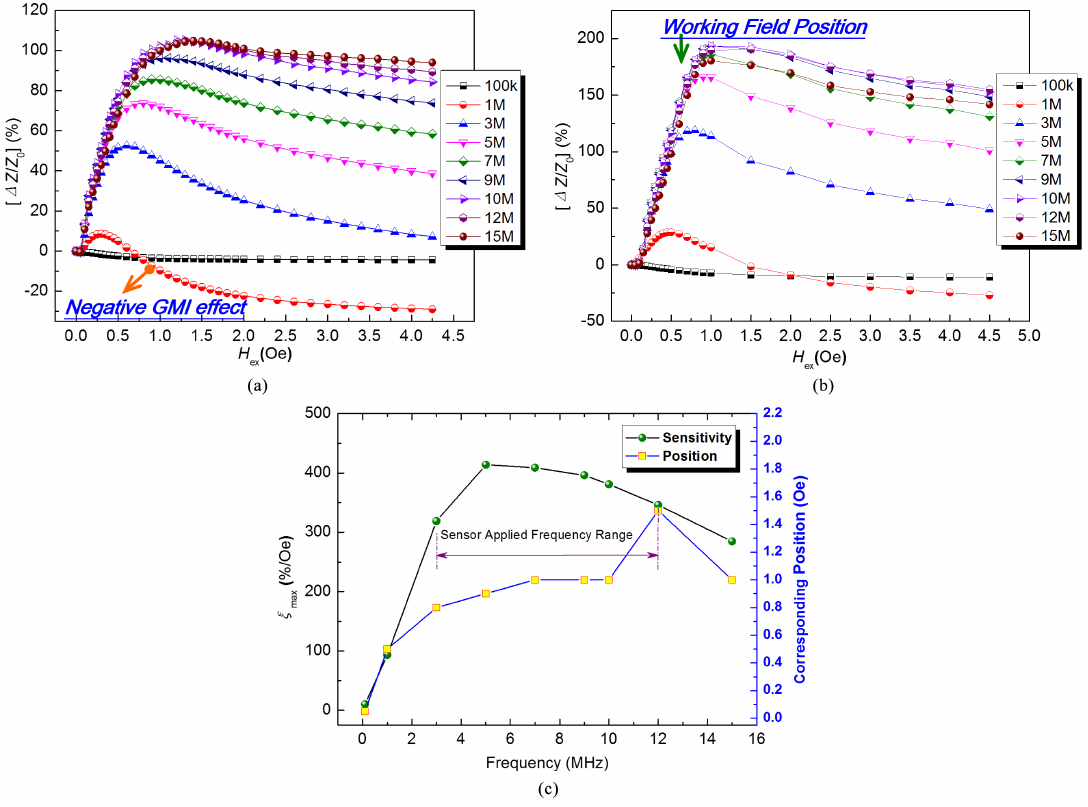
Figure 4. Variation curves of GMI ratio Δ Z / Z (b) microwires. Frequency dependence of magnetic field response sensitivity ξ selected frequencies of SPCJA-ed microwire. The bidirectional arrow in (c) indicates the sensor applied frequency range of